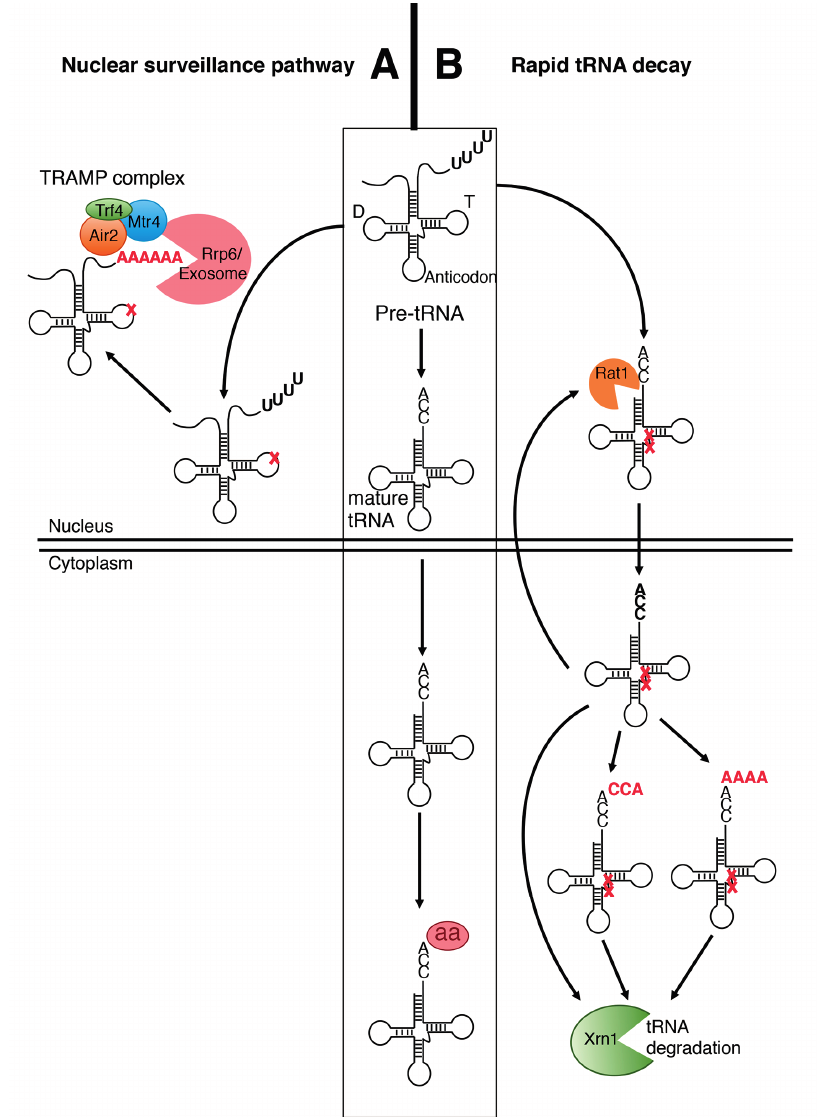
Figure 1. Overview of the two tRNA degradation pathways of S. cerevisae. This figure is adapted from [10]. ( A ) The tRNA nuclear surveillance pathway was primarily shown to act on pre-tRNAs lacking modifications (e.g., pre-tRNA iMet ). Hypo-modified pre-tRNA is first polyadenylated by the TRAMP complex and then degraded by the exosome; ( B ) Degradation of mature tRNAs through the rapid tRNA decay (RTD) pathway. RTD was shown to act on hypo-modified tRNAs (marked with red crosses) (e.g., tRNA Val(AAC) ). The major components are depicted. The implication of the tRNA-nucleotidyl transferase (CCAse) enzyme in the RTD pathway is also presented [33]. A, CCA triplet or a short poly(A) tail (AAAA) depicted in red can be added by the CCAse enzyme. The loss of hypo-modified tRNAs is not dependent on Trf4 or Rrp6, implying that the TRAMP complex and the nuclear exosome are not implicated. Rather, other protein components belonging to the RTD pathway were genetically identified (Figure 1B). In the trm8 ∆ trm4 ∆ yeast mutant strain, the degradation and loss of aminoacylation of tRNA Val(AAC) is mediated by Met22 (Methionine-requiring protein 22) and the two 5'–3' exonucleases Rat1 (Ribonucleic-acid-trafficking protein 1) and